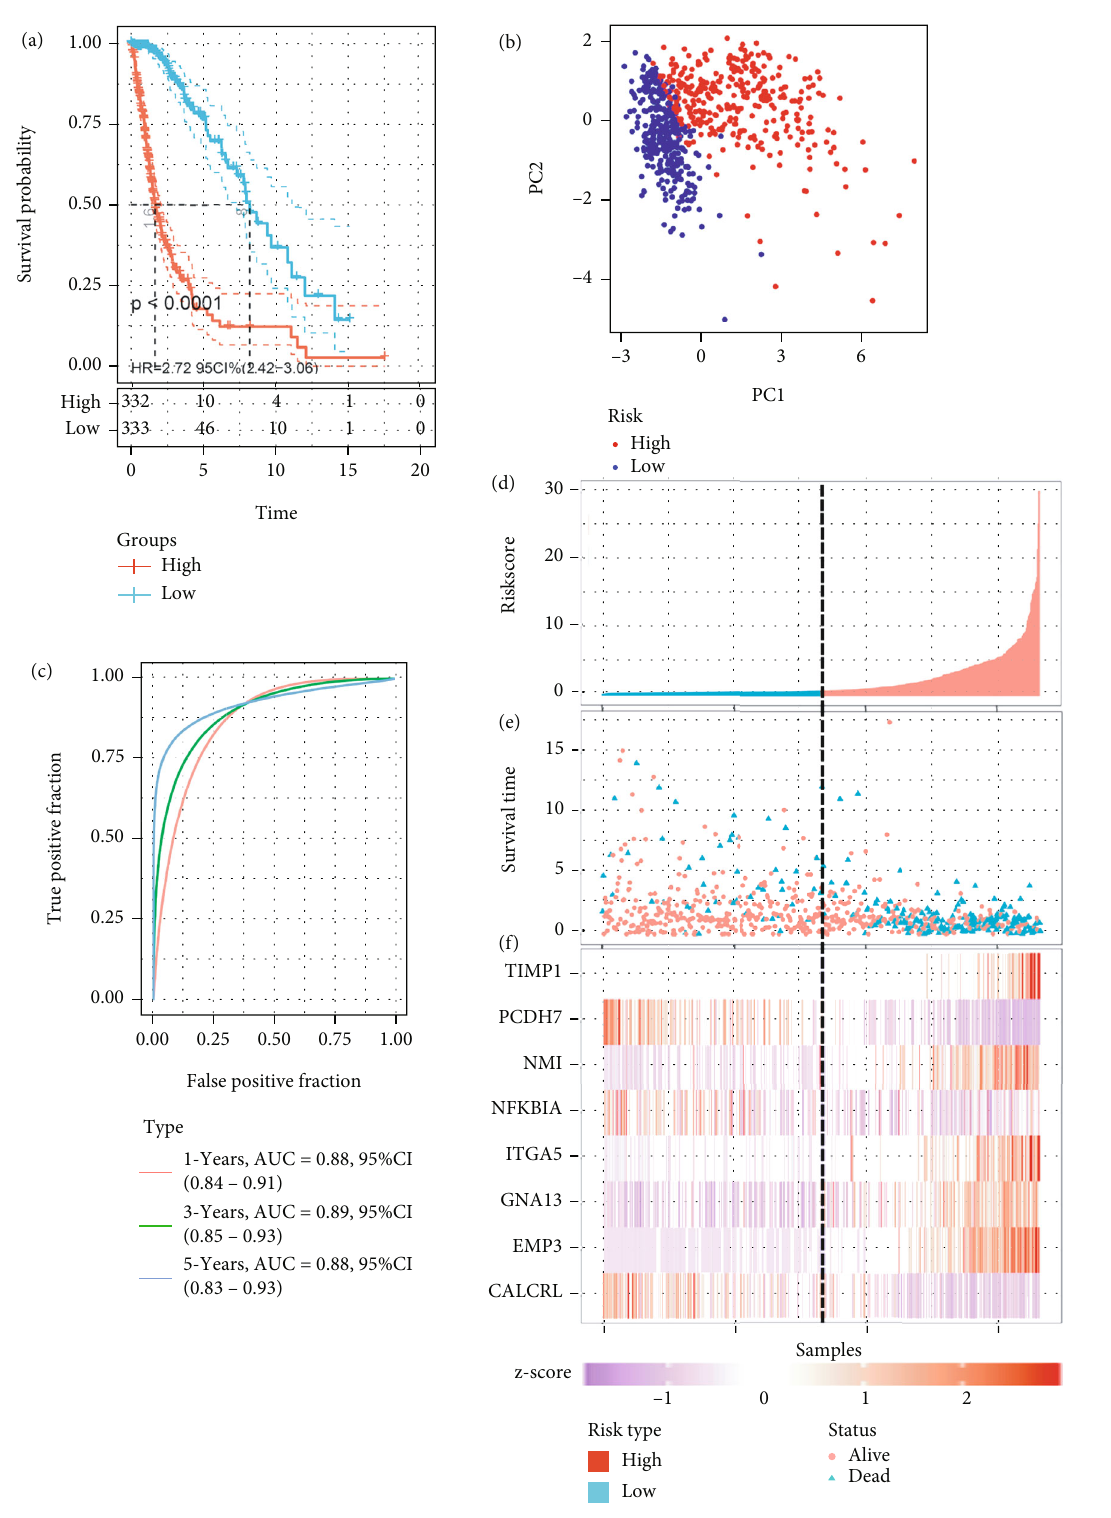
Figure 2: Prognostic analysis using the IRRG signature in TCGA cohort. (a) Kaplan – Meier curves for OS prediction in the low- and high- risk groups in TCGA cohort. (b) Principal component analysis (PCA) shows the separation between low- and high-risk groups in TCGA cohort. (c) The prognostic value of the IRRG signature at 1, 3, and 5 years via time-dependent ROC curve analysis in TCGA cohort. (d) The risk score distribution for each patient in TCGA cohort. (e) The distribution of survival time and survival status in TCGA cohort. (f ) The heat map shows that GNAI, EMP3, TIMP1, ITGA5, and NMI exhibit high expression levels, whereas PCDH7, NFKBIA, and CALCRL show low expression levels in TCGA